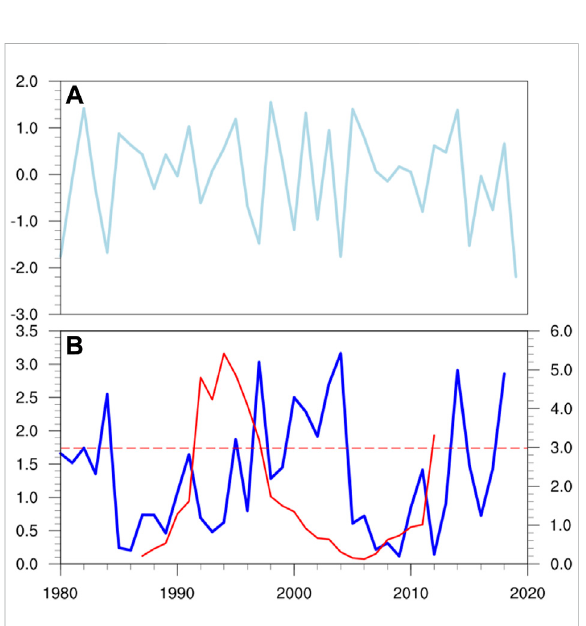
FIGURE 9 (A) Time Series and (B) absolute values of annual difference (blue line) and 10 years running F test values (red line) of SCSZWI (the red dashed line in b indicates signi fi cant values exceeding the 95% con fi dence level).